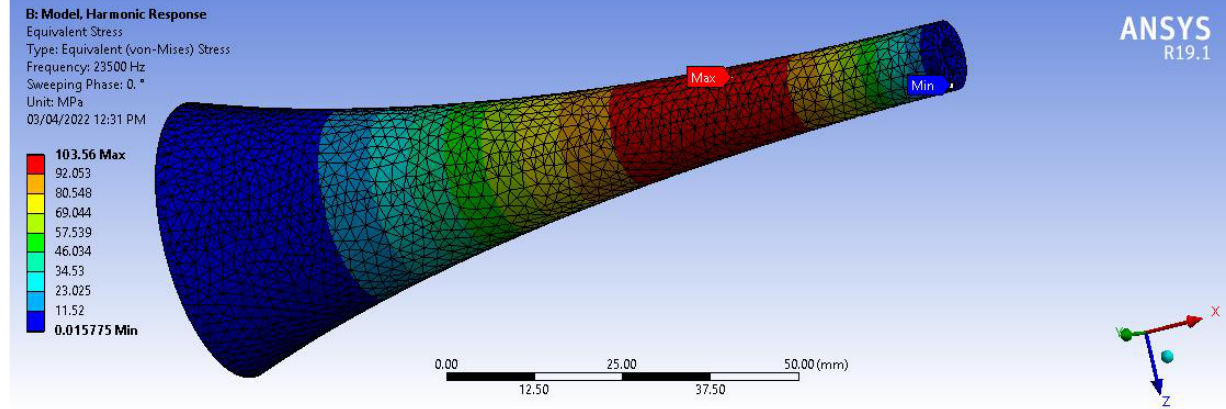
Figure 6. Variation of equivalent stress along the axial length of aluminum catenoidal horn